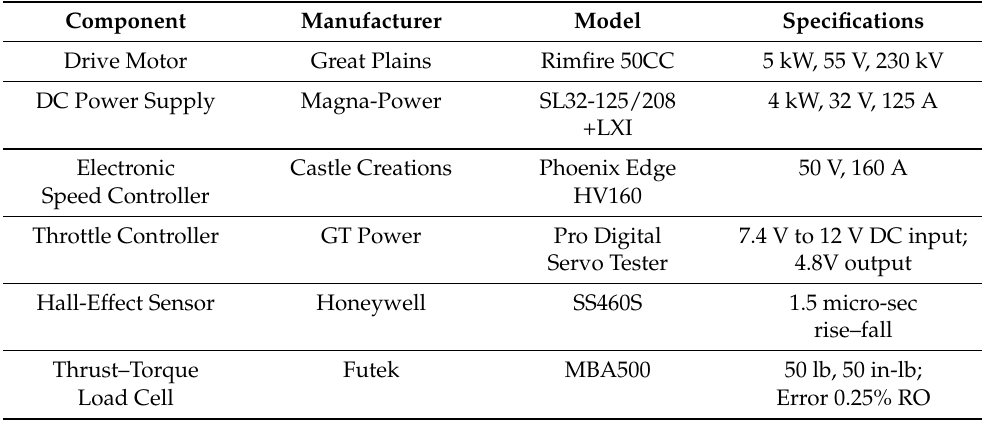
Table 1. Dynamometer electrical and instrumentation components.